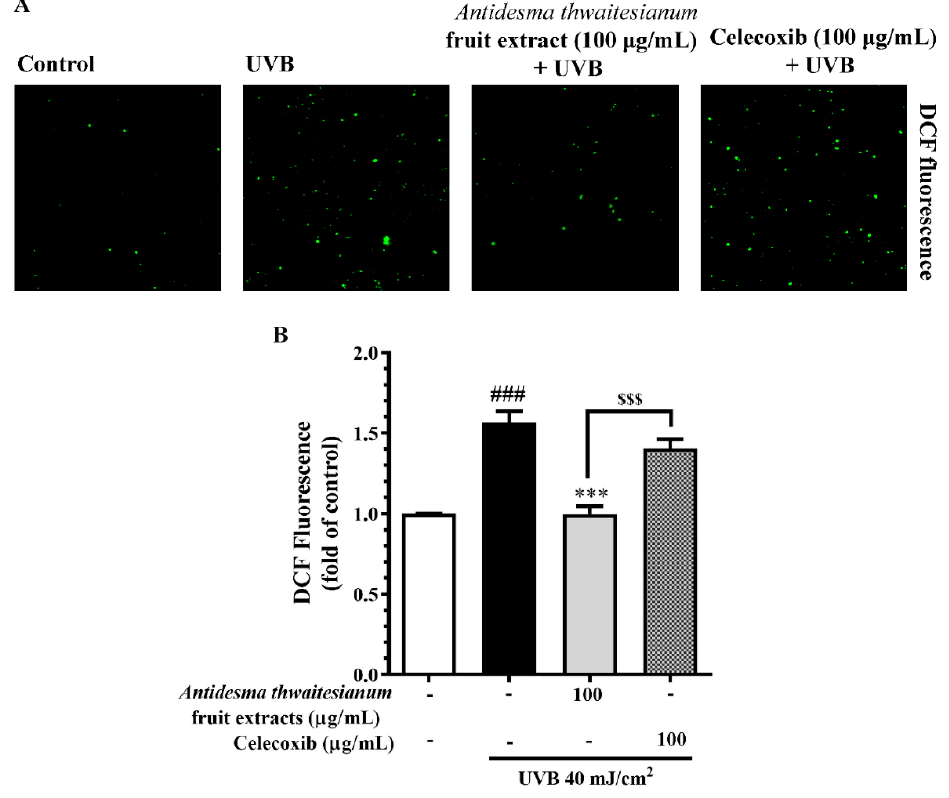
Figure 4. Intracellular ROS production was determined by H 2 DCFDA staining assay. The ROS scavenging effect of the fruit extract was monitored by the reduction in fluorescence. ( A ) shows the DCF fluorescent staining after pre-incubating with the fruit extract for 2 h, exposed to single UVB irradiation, and further incubating for 45 min. ( B ) shows the relative fluorescence intensities, which are presented as mean ± SEM (n = 6) and analyzed with Tukey’s test. ### p < 0.001 versus the control group, *** p < 0.001 versus UVB-irradiated cells alone. The statistical difference between the extract and celecoxib at 100 µg/mL was at $$$ p < 0.001.